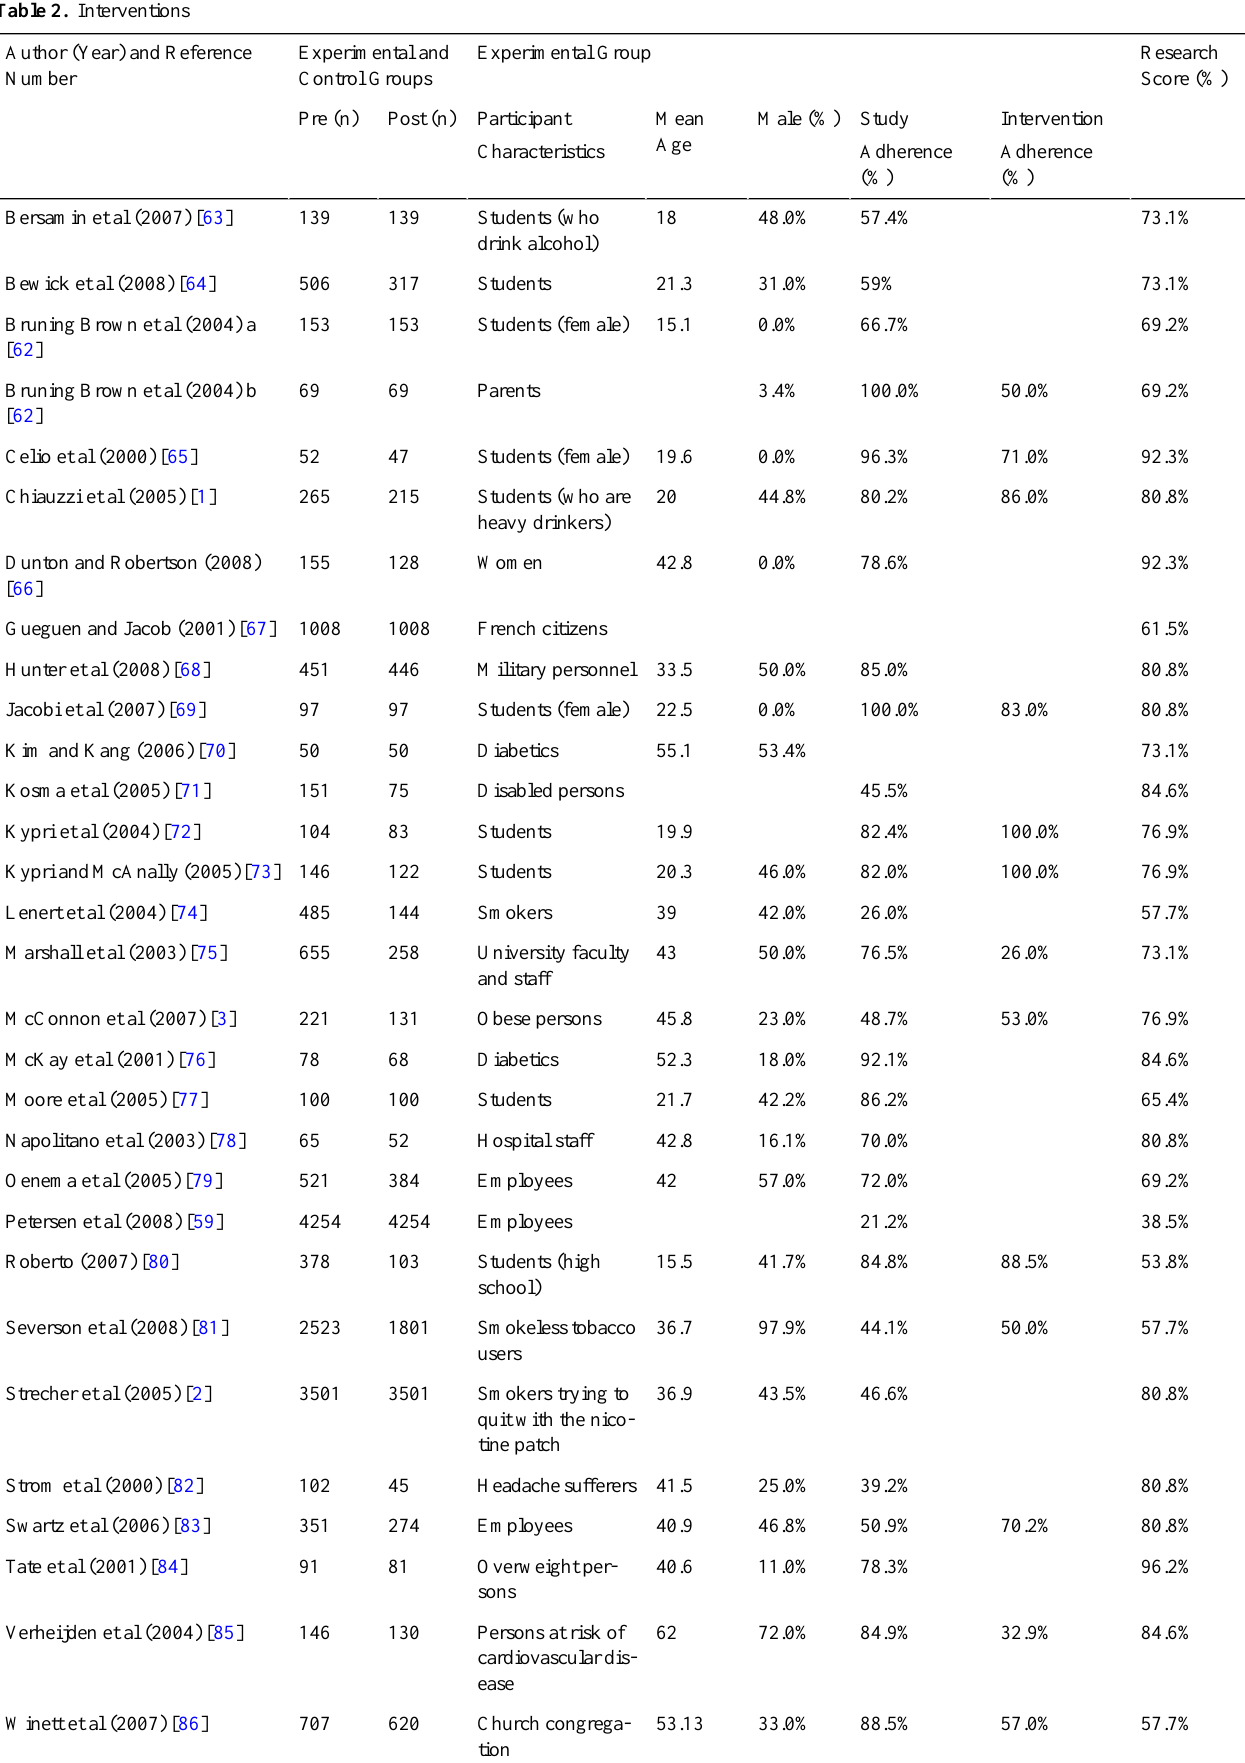
(%)Experimental GroupExperimental and